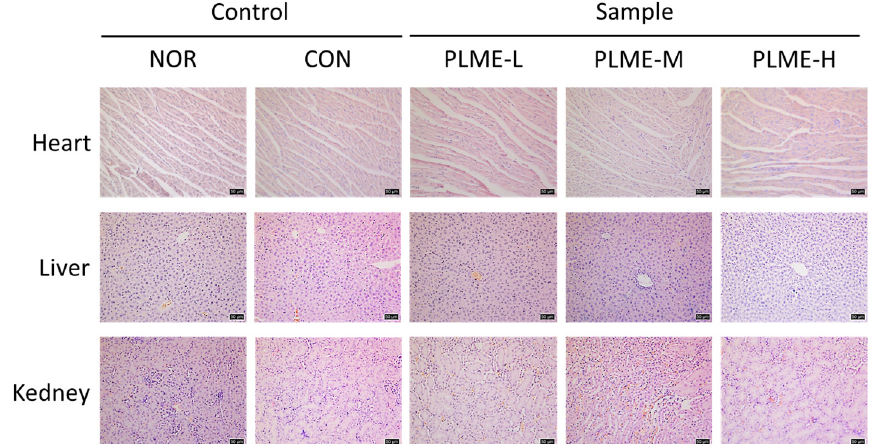
Figure 1. Histomorphometric analysis of major organs in mice administered with PLME for four weeks. Tissue biopsies of each organ were stained with H & E and observed under the microscope (magnification ×200). Scale bar = 50 μ m. NOR, normal group administered tap water; CON, medium control group administered only culture medium (250 mg/kg/day); PLME-L, PLME-M, and PLME-H, sample groups administered postbiotics prepared from P. linteus mycelial submerged culture at doses of 250, 500, and 1000 mg/kg bw/day, respectively.